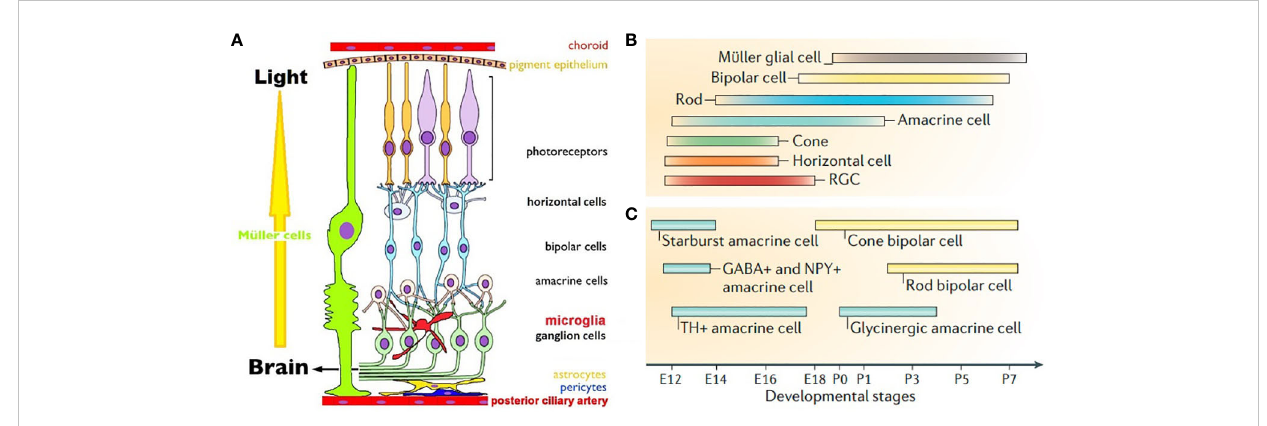
FIGURE 1 (A) . Schematic view of mammalian retina. Displaced RGCs, ACs and intra retinal blood vessels are not shown (7). (B) . Timeline of birth of retinal cells (C) . GABAergic ACs are born earlier than glycinergic ACs. Cone BPs are born before rod BPs. (B, C) are from Cepko, 2014